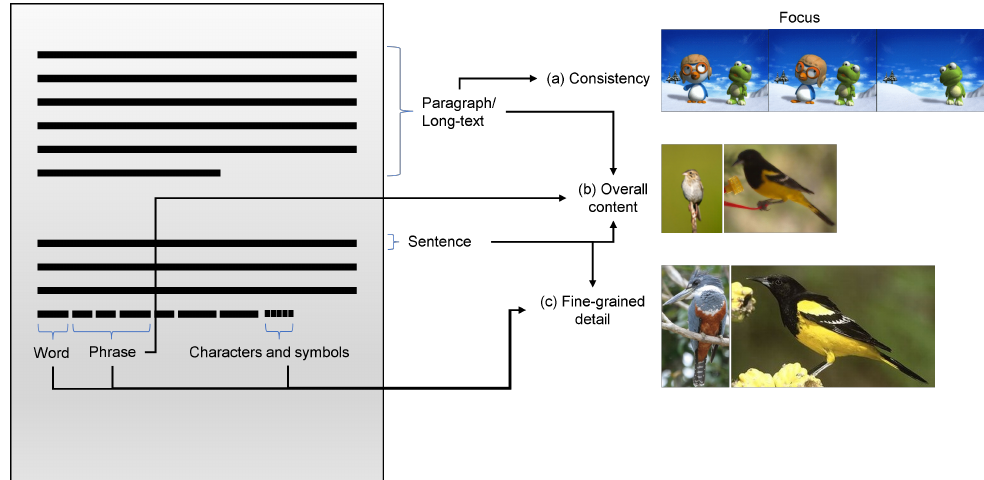
Figure 2. Representation of different types of text levels used in the T2Vo tasks, where different levels pay attention to one or more output detail. Figures obtained from (a) PororoQA, (b,c) CUB 2011 datasets, which represent the concept used in (a) [31], (b) [7,32], and (c)